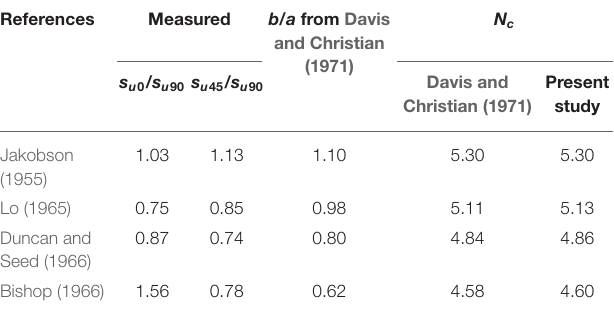
TABLE 1 | Comparison of available experimental results with the present